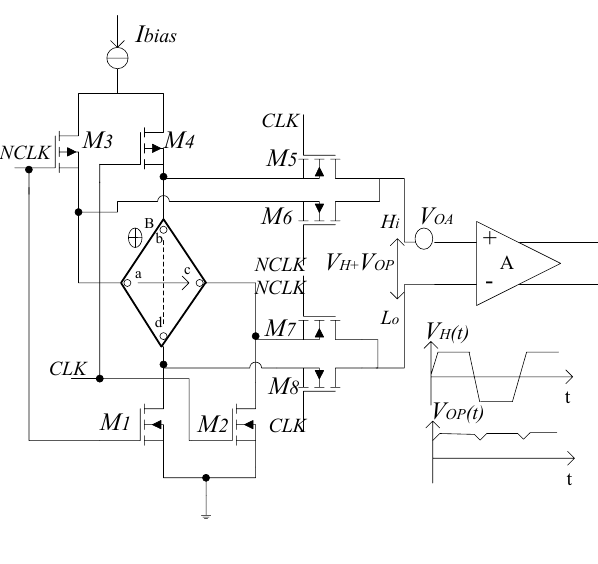
Figure 3. Switched Hall